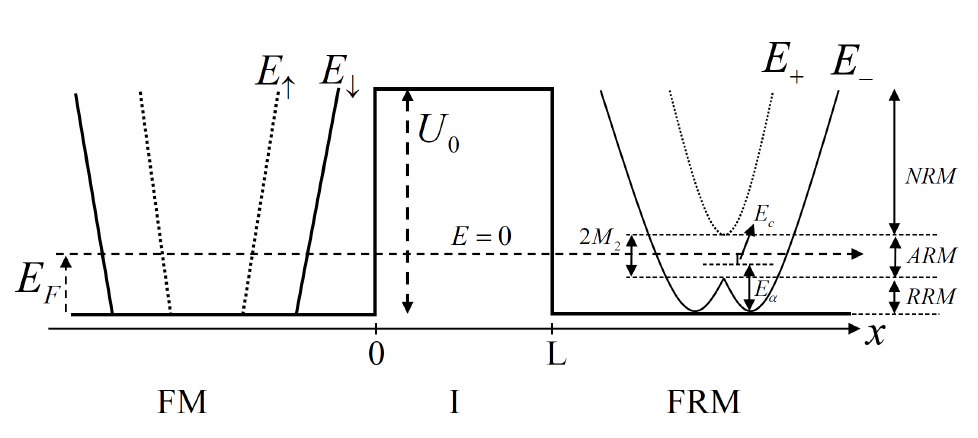
Figure 1. A schematic diagram of the energy spectra of electron in FM/I/FRM junction, the parame- ters were displayed in the